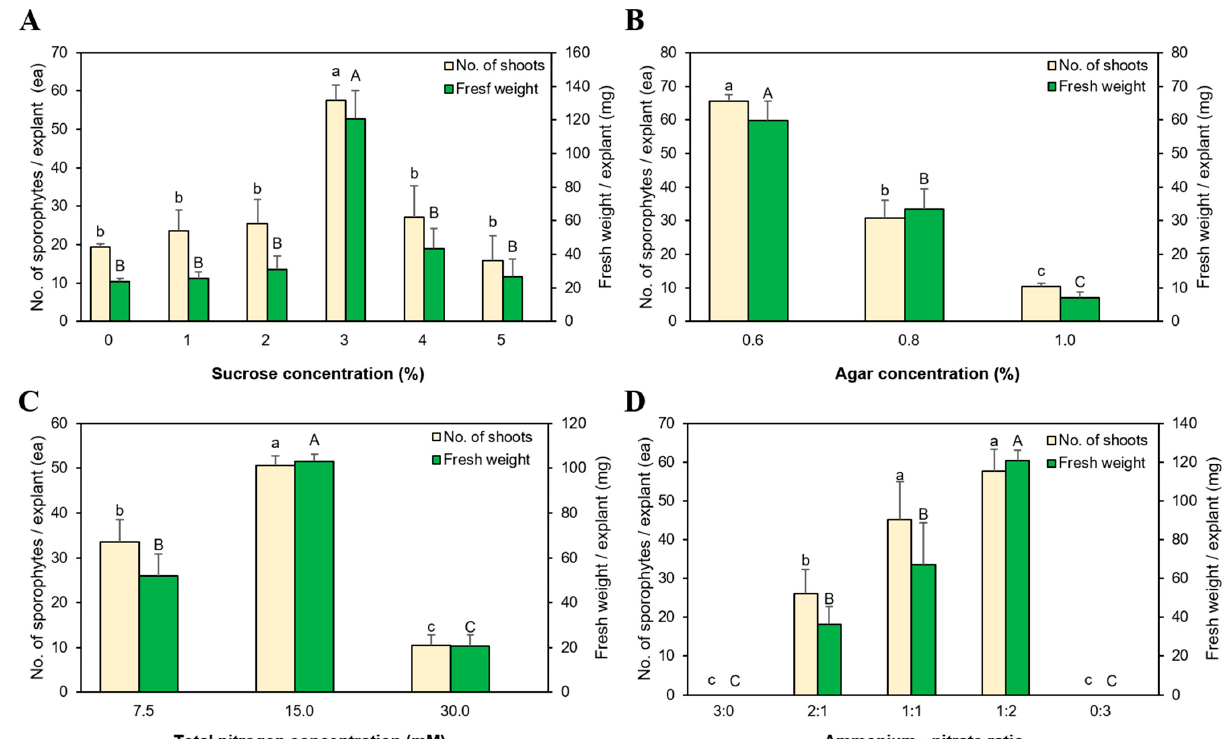
Figure 2. Effect of medium components on S. tamariscina (P.Beauv.) Spring growth and sporophyte regeneration. Results according to various ( A ) sucrose, ( B ) agar, and ( C ) total nitrogen concentrations, as well as ( D ) nitrogen ratios, following 12-week in vitro culture. Small letters and capital letters above the bars indicate the statistical difference of a number of sporophytes and fresh weight, respectively, by Duncan’s multiple range test at p < 0.05.